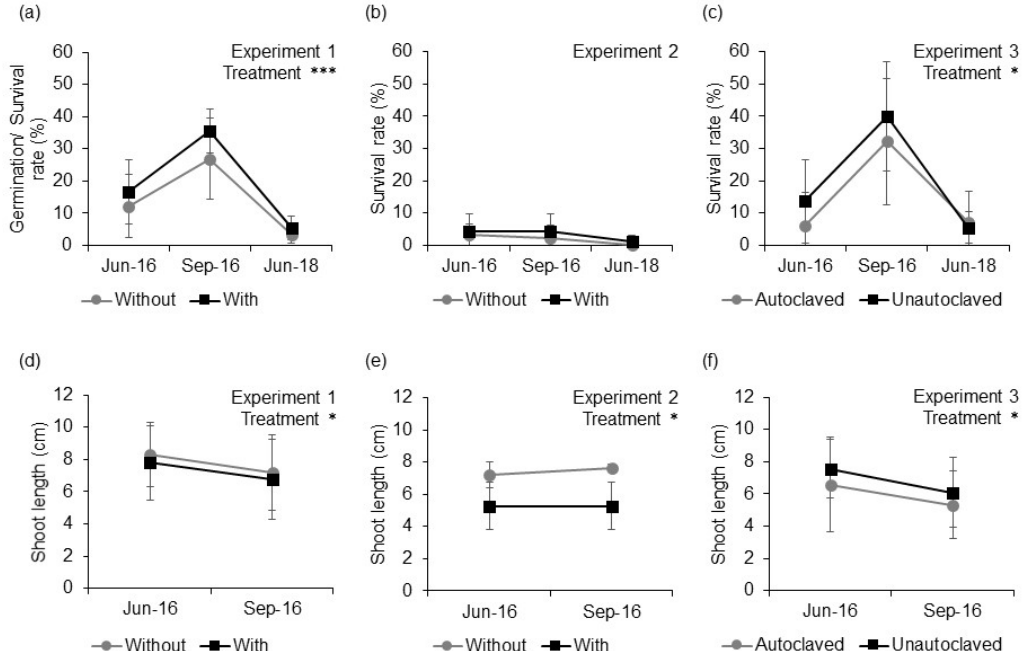
Figure 1. The germination/survival rates ( a ), survival rates ( b , c ), and the aboveground height ( d – f ) of the sow/planted seedlings. Values are means ± SD. The asterisk on “Treatment” means p -values (* p < 0.05, *** p < 0.001) based on ANOVA for the GLMM ( a – c ) or LMM ( d – f ) with the treatment (with/without oak forest soils in Experiment 1 and 2, autoclaved/unautoclaved oak forest soils in Experiment 3) and recording occasion. The models were performed with the plot as a random variable. ( a , d ) Differences between sowing seeds with or without oak forest soils in Experiment 1, ( b , e ) differences in transplanting wild seedlings with or without oak forest soils in Experiment 2, ( c , f ) differences in transplanting seedlings inoculated in autoclaved or unautoclaved oak forest soils in Experiment 3.